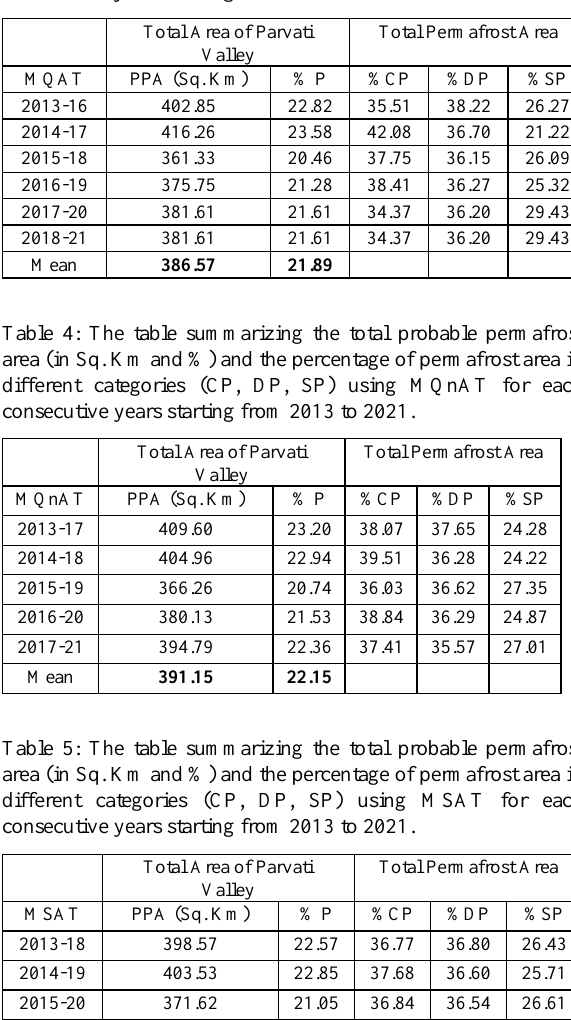
Table 3: The table summarizing the total probable permafrost area (in Sq. Km and %) and the percentage of permafrost area in different categories (CP, DP, SP) using MQAT for each consecutive years starting from 2013 to 2021.